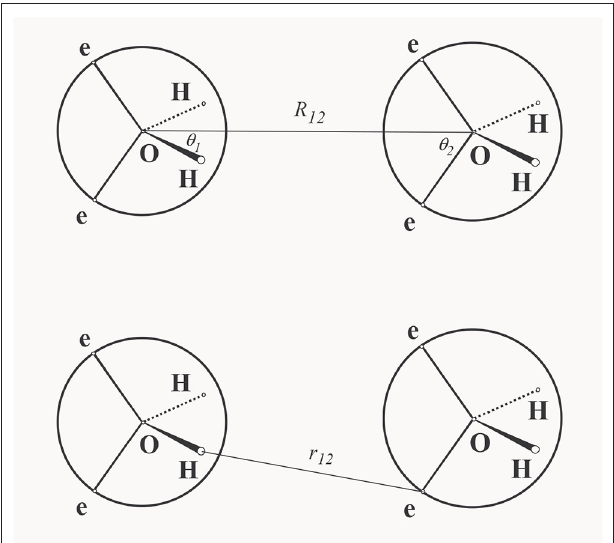
FIGURE 4 | Schematic representation of the H-bonding: Bol’s notation (upper) and Smith-Nezbeda’s notation (lower)